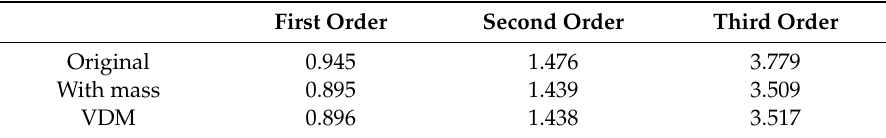
Table 2. First three natural frequencies